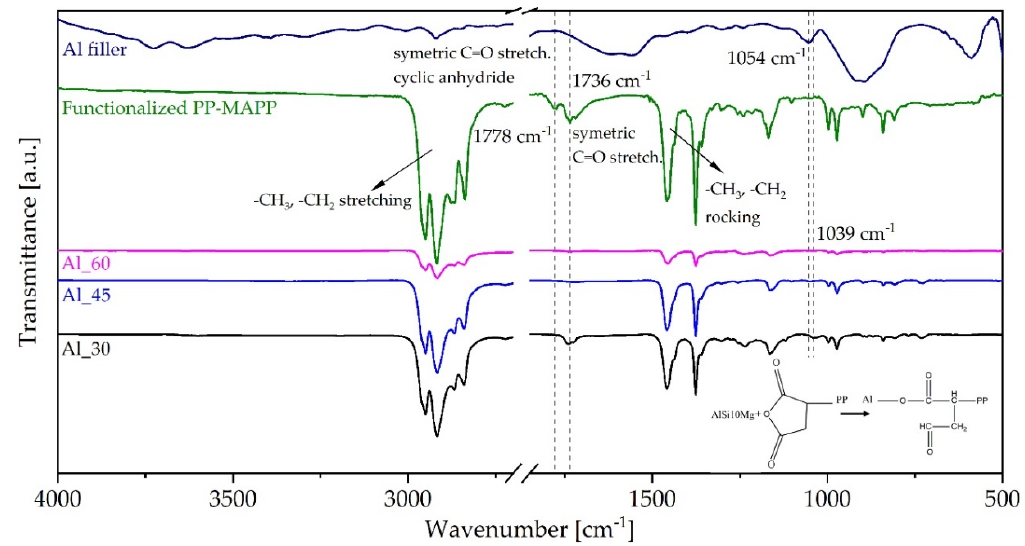
Figure 10. ATR-FTIR spectra of Al materials, reference binder system and Al filler material.